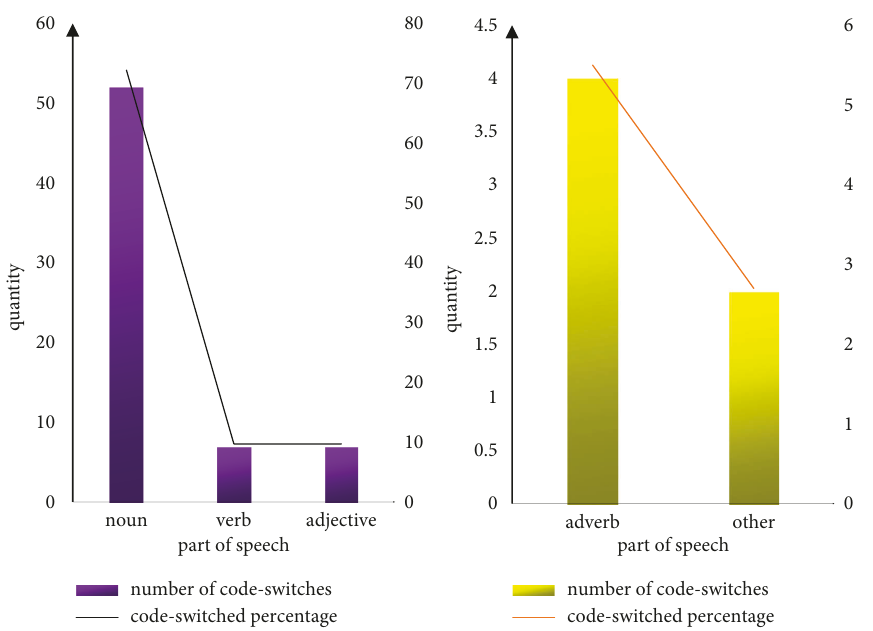
Figure 8: Part-of-speech distribution for code-switching. Table 3: Distribution of code-switching in spoken and written languages.